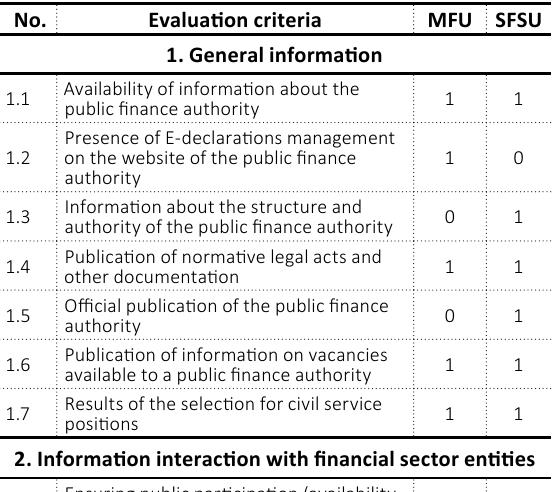
Table 5. Distribution of points in the system of indicators of transparency by the level of availability and completeness of information disclosed by the Ministry of Finance of Ukraine